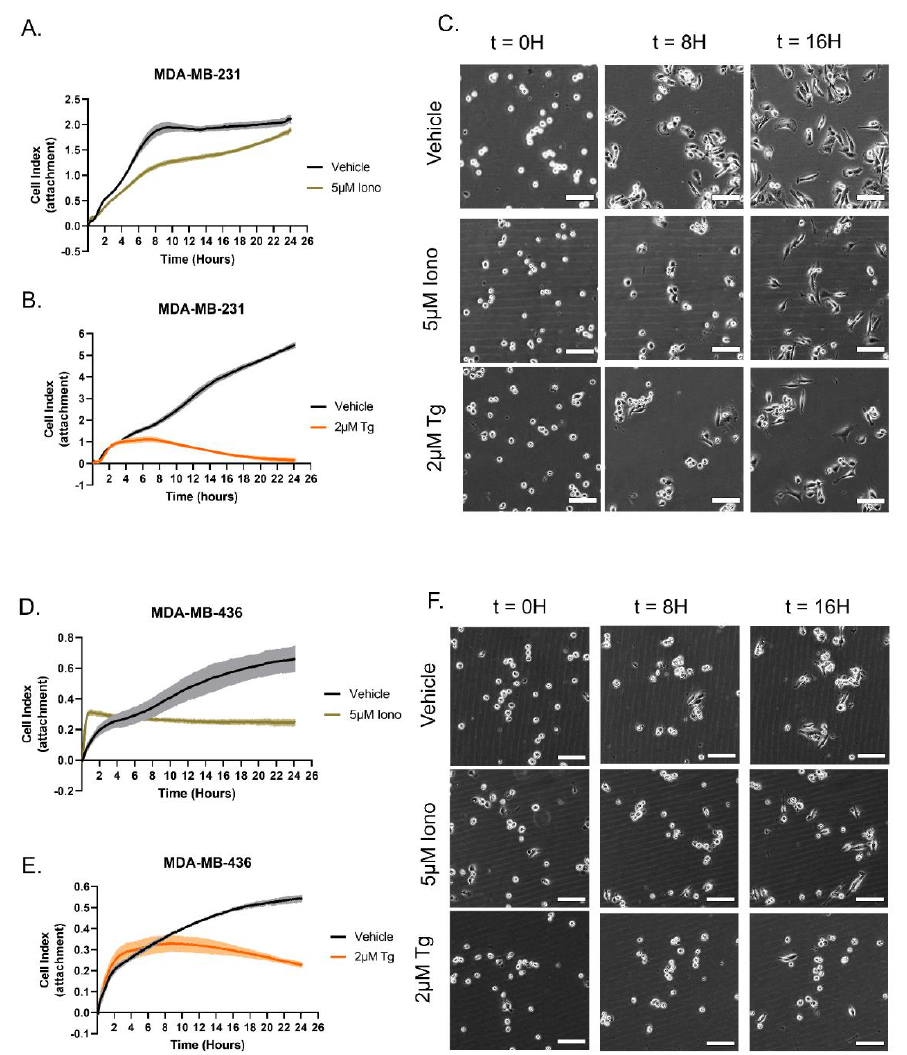
Figure 4. Ionomycin or Thapsigargin treatment inhibits cellular reattachment in MDA-MB-231 and MDA-MB-436 cells. ( A ) Representative graph shows treatment with Ionomycin reduces initial attachment and spreading but recovers over time in MDA-MB-231 cells. ( B ) Representative graph shows Thapsigargin treatment significantly inhibits cellular reattachment over time in MDA-MB-231 cells. ( A , B ) Technical quadruplicates with data shown as mean ± SD. ( C ) Enlarged representative cell population images extracted from 17 h time course video. At time points 0, 8, and 16 h, MDA-MB-231 cells are visualized attaching to the bottom of the tissue culture-treated plate in either vehicle control, 5 µ M Ionomycin or 2 µ M Thapsigargin treatments. ( D ) Representative graphs shows 5 µ M Ionomycin-treated MDA-MB-436 cells have a decreased reattachment trend in comparison to the vehicle control. ( E ) Representative graphs show Thapsigargin-treated MDA-MB-436 cells have a decreased reattachment trend in comparison to the vehicle control. ( D – E ) Data shown as mean ± SD of technical triplicates. ( F ) Representative enlarged region of interest populations of interest were extracted from a 17 h time course video. At time points 0, 8, and 16 h MDA-MB 436 cells were visualized attaching to the bottom of the tissue culture-treated plate with either vehicle control, 5 µ M Iono, or 2 µ M Tg. ( C , F ) The time course video was taken on the Nikon Eclipse Ti2-E inverted microscope using a 10 × phase contrast air objective with the Tokai-Hit incubation stage. Scale bar = 100 μM .